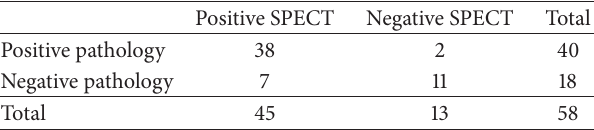
Table 3: SPECT and pathological